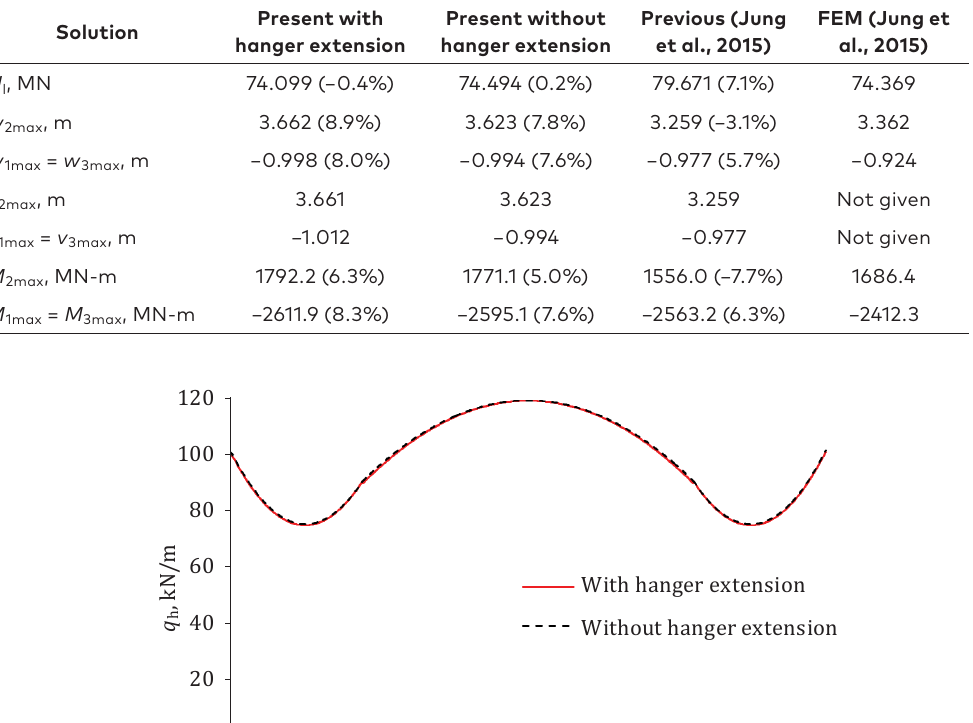
Table 2. Comparison of solutions using different